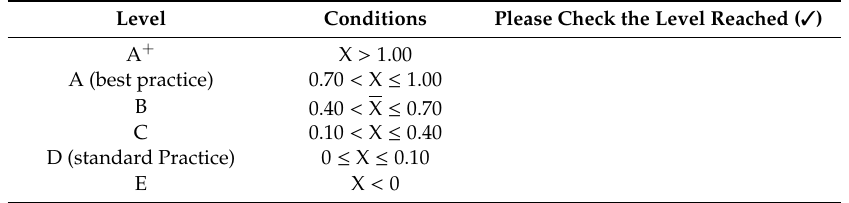
Table 1. General evaluation of dimension, categories, and indicators, [1,4] for the Sustainability Assessment of High School Buildings in Portugal (SAHSB PT )